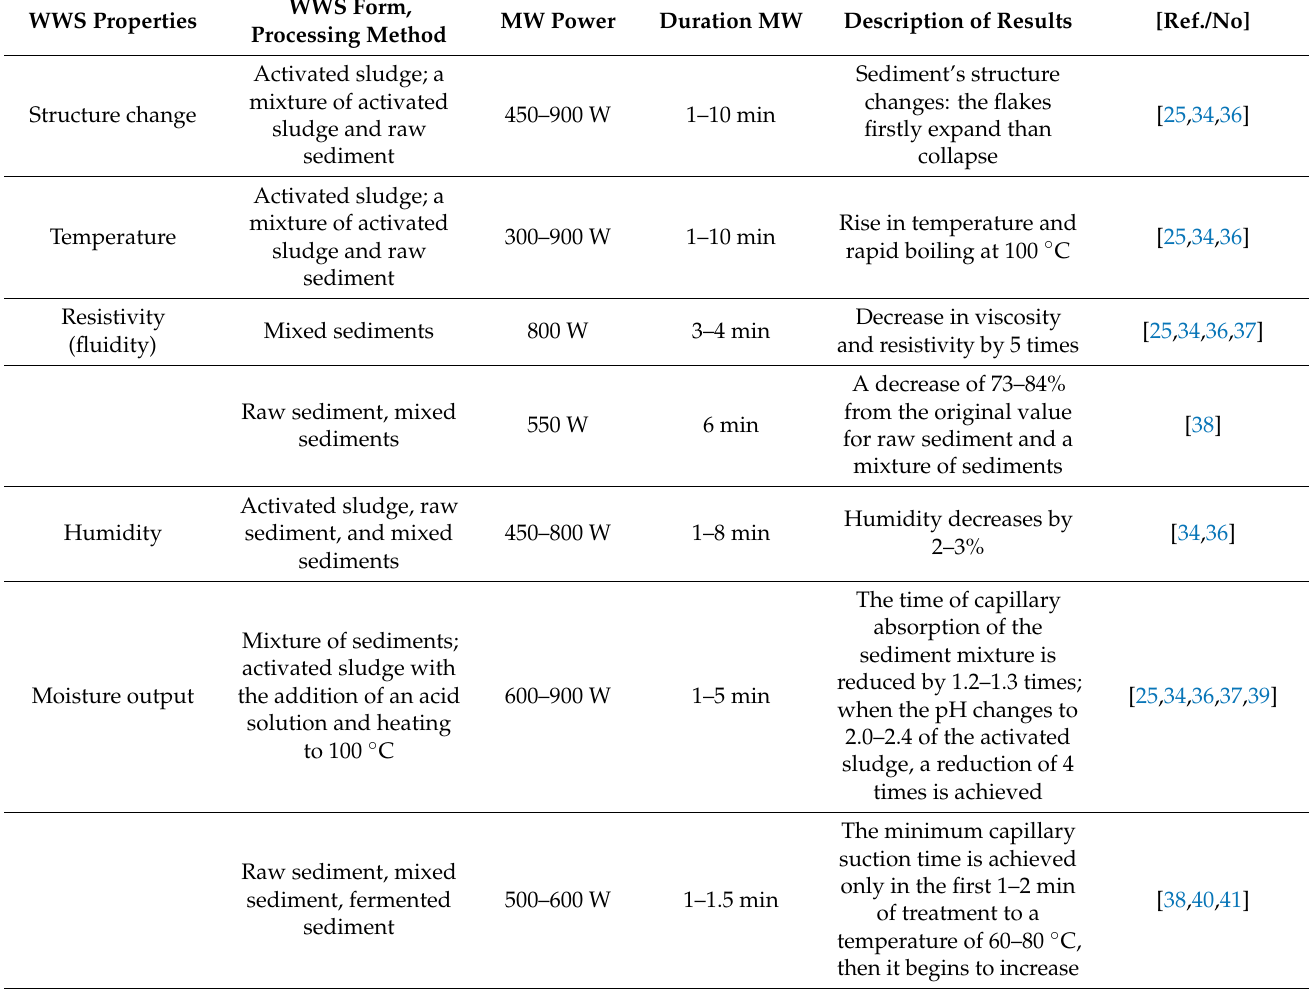
Table 5. Changes in the physical and chemical properties of WWS under the influence of